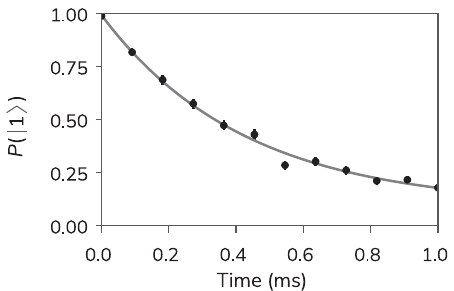
FIG. 11. Estimating the scattering rate of the Z beam. The spins are prepared in the j 1 i state and the Z beam is turned on for the time shown. Scattering causes the spin to relax to a population set by the branching ratios from the two excited levels that the Z 1 = 2 i and j F 0 ¼ 3 = 2 ; beam scatters from: j F 0 ¼ 3 = 2 ; m F 0 ¼ þ 3 = 2 i . The decay timescale is 0.43(4) ms, consistent m F 0 ¼ þ with the scattering rate estimated from the observed differential light shift produced by this beam. The error bars correspond to standard deviations of the binomial distributions given by the measured